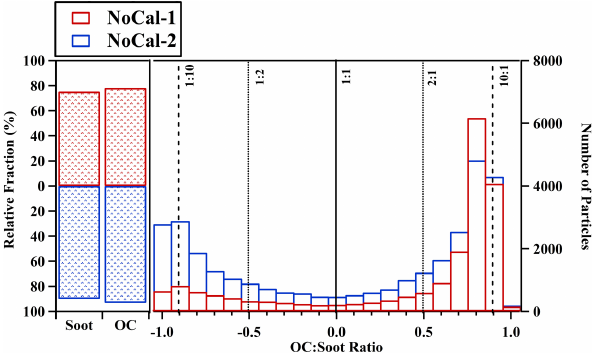
Fig. 9. Fraction of particles containing soot and OC with RPA > 0.5% in NoCal-1 (blue) and NoCal-2 (red) (left panel). OC:soot ion ratio distribution are shown in (right panel). Values < 0 indicate more soot than OC and values > 0 indicate more OC than soot. Ra- tios representing 1:1, 2:1, and 10:1 are shown by solid, dotted, and dashed lines respectively.